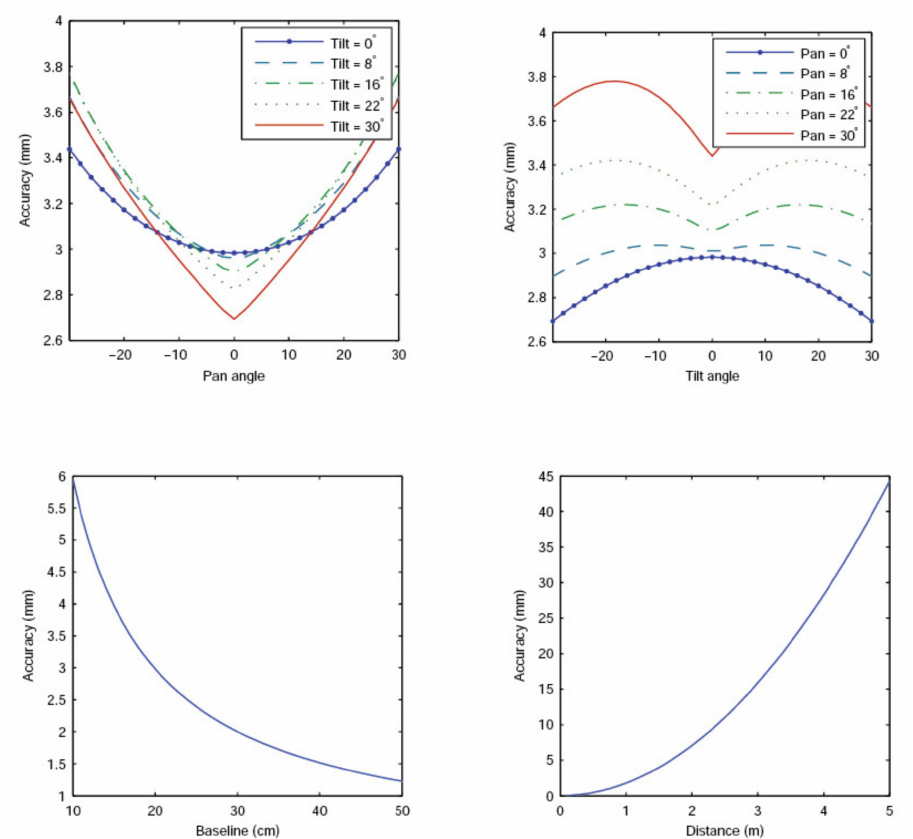
Figure 2. Theoretical reconstruction accuracy with respect to three dynamic parameters (pan, tilt, baseline) and distance. When variables are not given, default values are used: pan = 0 ◦ , tilt = 0 ◦ , precision of encoders ± 0.0055 ◦ , baseline = 20 cm, operating distance = 1.5 m, focal length of the cameras = 8 mm, pixel size = 5.7 mm, image resolution = 640 × 480, precision of stereo matching = ± 0.1 pixel. Top-left/right: reconstruction accuracy as a function of pan/tilt angle. Bottom left/right: reconstruction error as a function of baseline/distance. Baseline is in cm while Distance to object is in